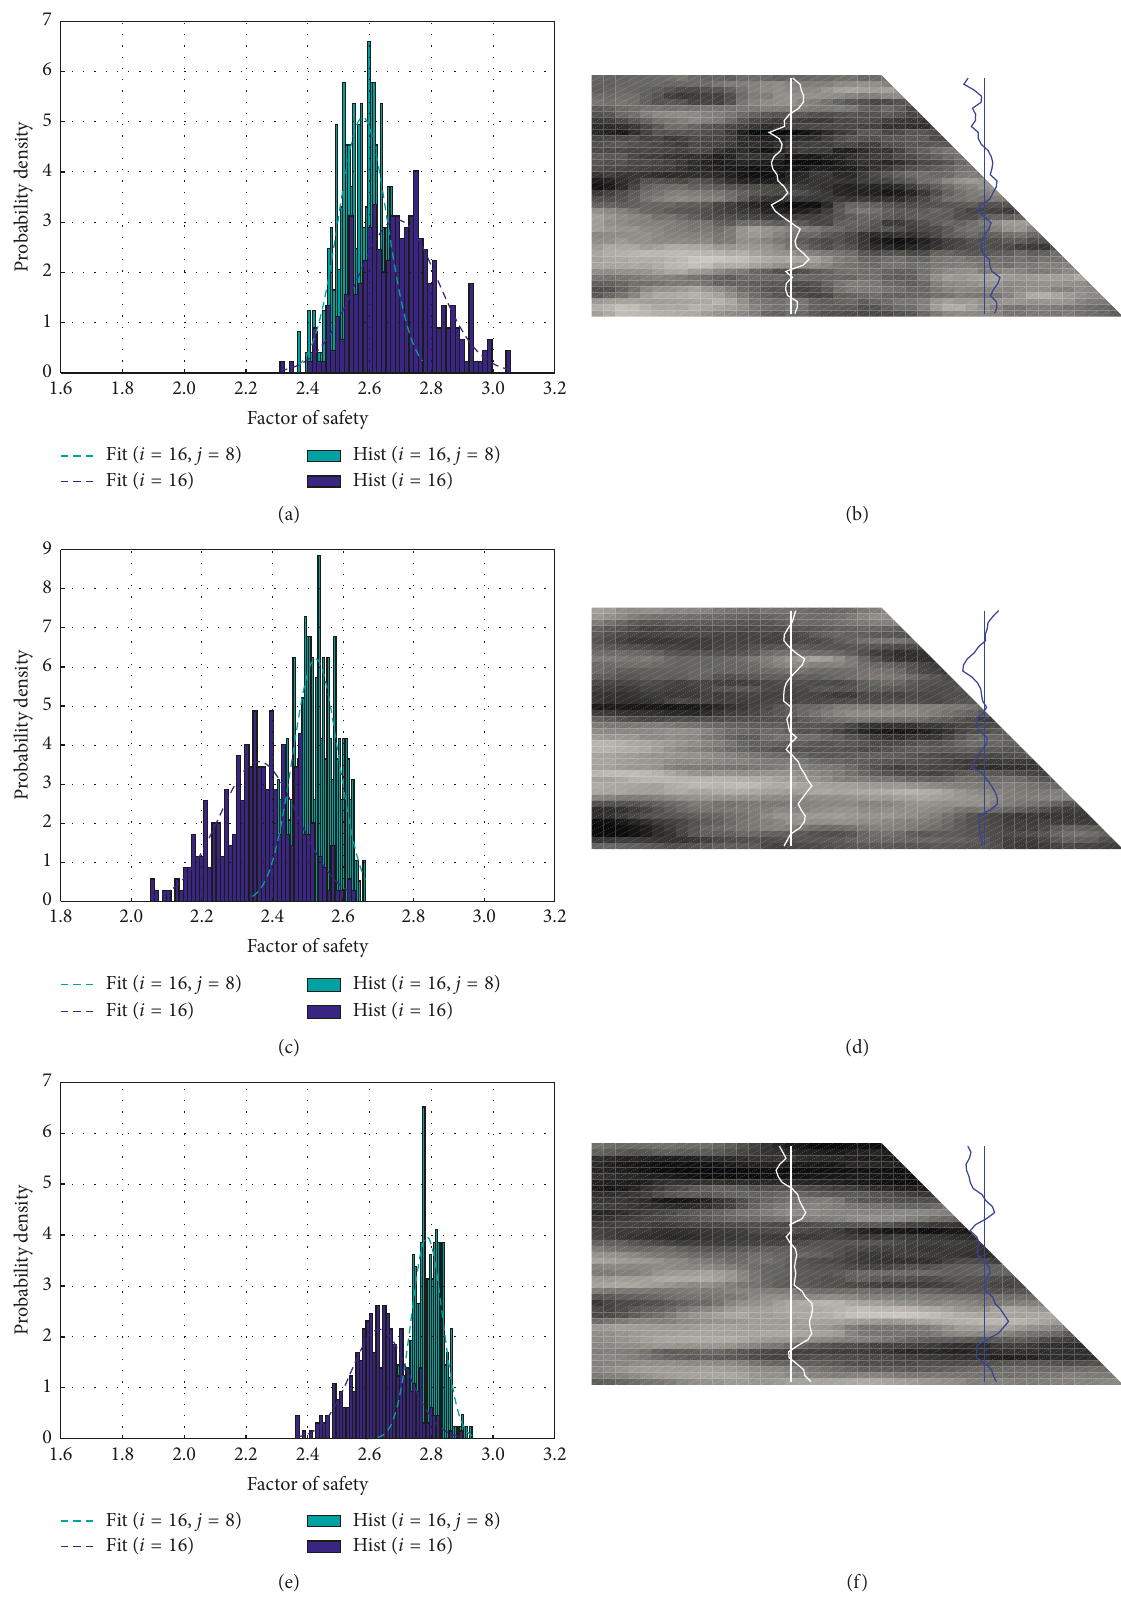
Figure 9: Simulation results in the second phase of example 1 (based on θ phase CPT location fixed at i � 16, second phase CPT location j � 8): (a–b) θ factor of safety. (b) Example realisation and CPT. (c) PDF of realised factor of safety. (d) Example realisation and CPT. (e) PDF of realised factor of safety. (f) Example realisation and